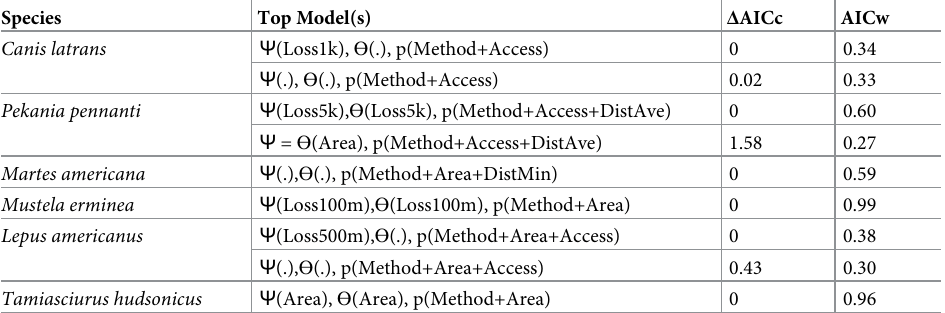
Table 2. Top-ranked occupancy models for six species surveyed with camera trap transects in Maine, USA, 2017. Species Top Model(s) Δ AICc AICw Canis latrans Ѱ (Loss1k), ϴ (.), p(Method+Access) 0 0.34 Ѱ (.), ϴ (.), p(Method+Access) 0.02 0.33 Pekania pennanti Ѱ (Loss5k), ϴ (Loss5k), p(Method+Access+DistAve) 0 0.60 Ѱ = ϴ (Area), p(Method+Access+DistAve) 1.58 0.27 Martes americana Ѱ (.), ϴ (.), p(Method+Area+DistMin) 0 0.59 Mustela erminea Ѱ (Loss100m), ϴ (Loss100m), p(Method+Area) 0 0.99 Lepus americanus Ѱ (Loss500m), ϴ (.), p(Method+Area+Access) 0 0.38 Ѱ (.), ϴ (.), p(Method+Area+Access) 0.43 0.30 Tamiasciurus hudsonicus Ѱ (Area), ϴ (Area), p(Method+Area) 0 0.96 The models shown are the top ranked model using Akaike’s information criterion corrected for small samples